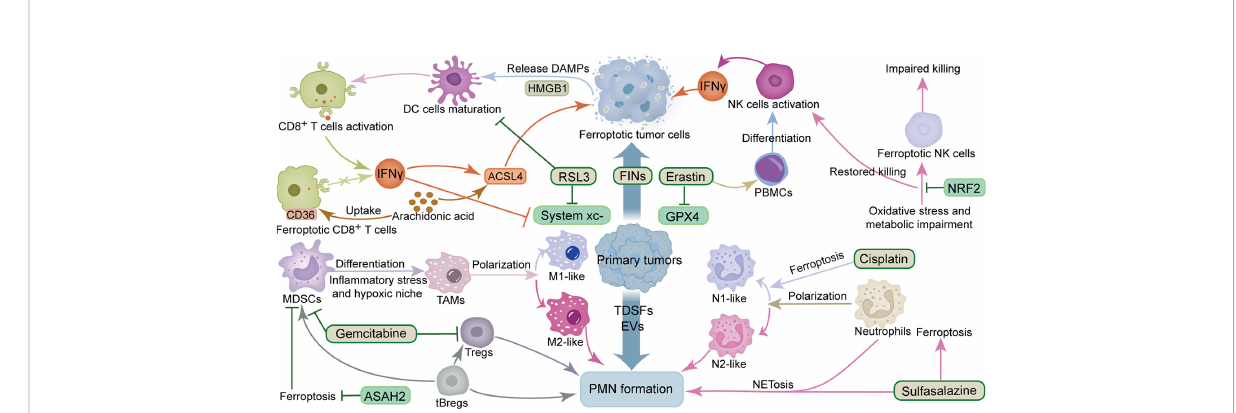
FIGURE 1 Crosstalk between ferroptosis and immunosuppression and in fl ammation in PMN. The ingredients that promote the formation of PMN include TDSFs, EVs, MDSCs, M2-like TAMs, tBregs, Tregs and N2-like neutrophils. The components that inhibit the formation of PMN include IFN g , DC cells, NK cells, M1-like TAMs, N1-like neutrophils and CD8 + T cells. The ingredients that promote ferroptosis include RSL3, erastin, gemcitabine, sulfasalazine, cisplatin, IFN g , ACSL4 and arachidonic acid. The components that inhibit ferroptosis include GPX4 and system xc-. ACSL4, acyl- CoA synthetase long-chain family member 4; ASAH2, N-acylsphingosine amidohydrolase 2; DAMPs, damage-associated molecular patterns; DC cells, dendritic cells; EVs, extracellular vesicles; FINs, ferroptosis inducers; GPX4, glutathione peroxidase 4; HMGB1, high mobility group box 1 protein; IFN g , interferon g ; MDSCs, myeloid-derived suppressor cells; NK cells, natural killer cells; NRF2, nuclear factor E2-related factor 2; PBMCs, Peripheral blood mononuclear cells; PMN, pre-metastatic niche; TAMs, tumor-associated macrophages; tBregs, tumor-evoked regulatory B cells; TDSFs, tumor-derived secreted factors; Tregs, regulatory T